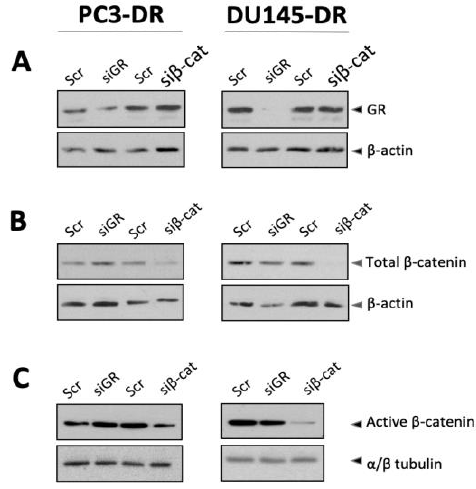
Figure 5. The expression of GR and β-catenin in DTX-resistant PCa cells is not inter-dependent. siRNA-mediated knockdown of GR or β-catenin was achieved in PC3-DR and DU145-DR using 100 nM each of non-specific scrambled oligo (Scr), siRNAs specific for GR (siGR), or siRNAs specific for β-catenin (siβ-cat) for 24 h. Knockdowns were detected by immunoblotting using specific antibodies for GR ( A ), total β-catenin ( B ), and active β-catenin ( C ) in PC3-DR and DU145-DR lysates. β -actin and αβ -tubulin were used as loading controls.